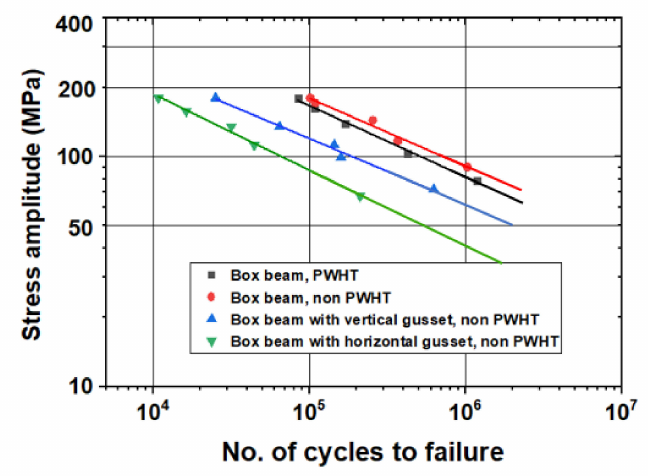
Figure 23. S-N curves of real-size